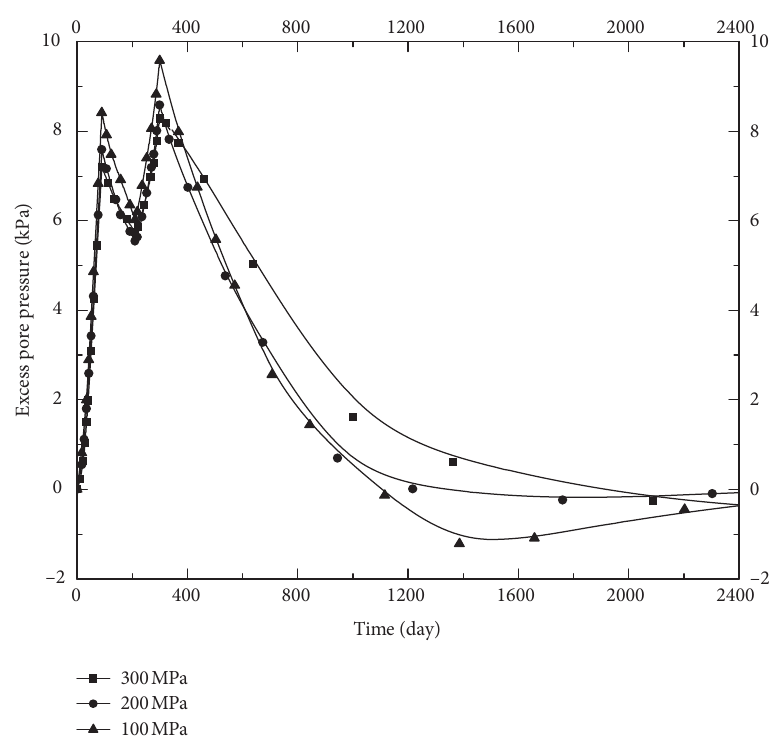
Figure 13: Excess pore pressure versus time with different elastic modulus of